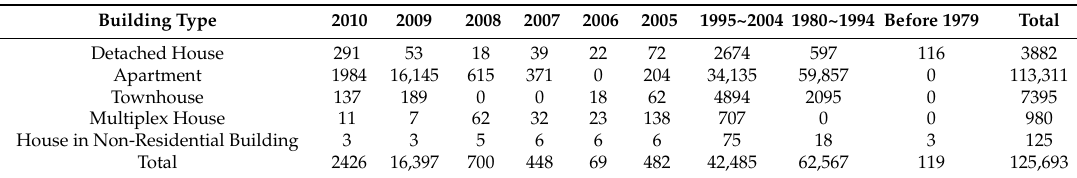
Table 1. Bundang 2010 residential building statistics.